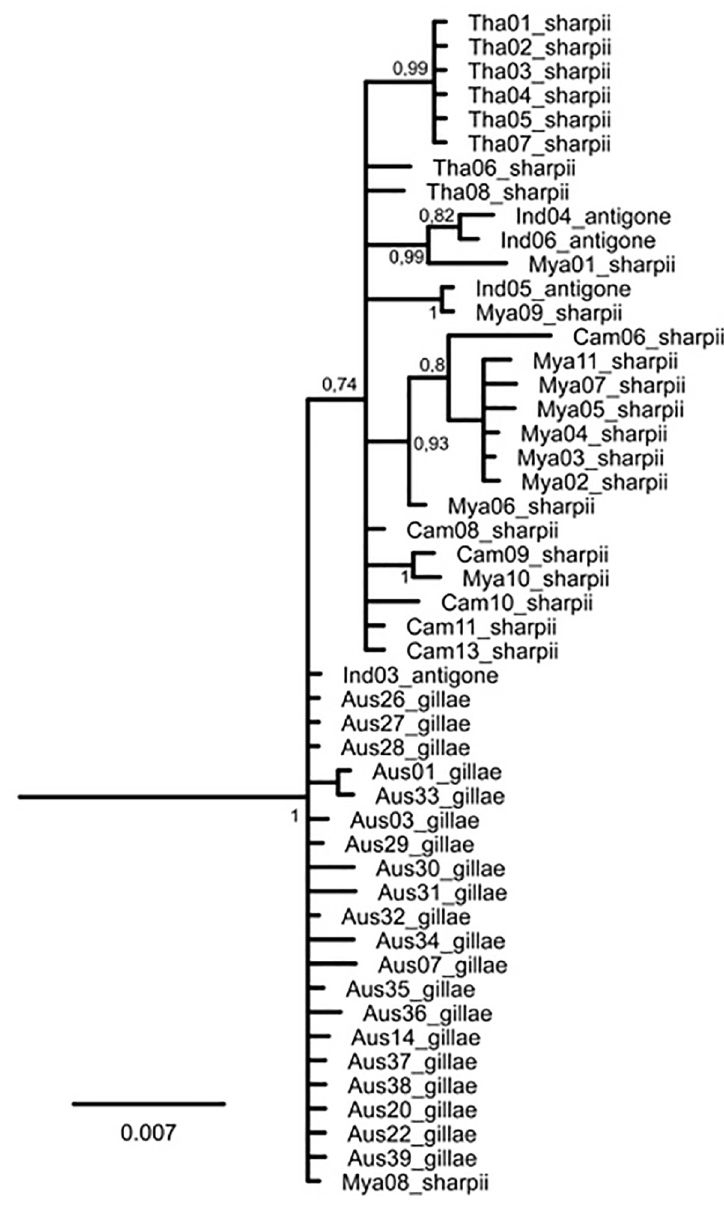
Fig 4. Phylogenetic tree for three subspecies of the Sarus Crane A . antigone ; based on mtDNA sequences resulting from Bayesian analysis. Posterior probabilities are given if > 0.70 (for sample codes see Table 2; outgroup ( A . rubicunda ) pruned